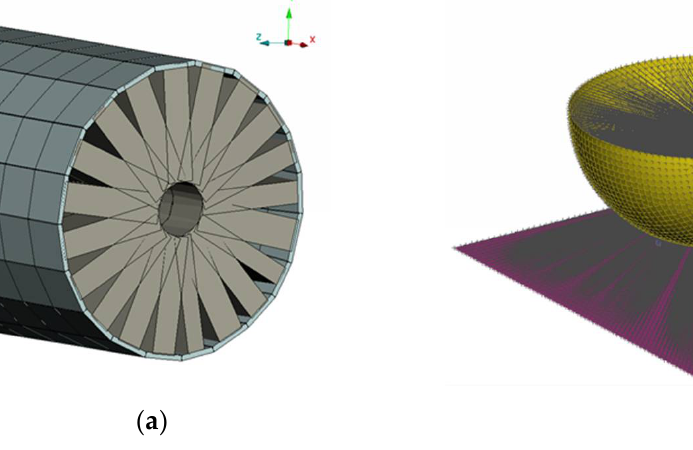
Figure 12. Finite element model of impacted battery: ( a ) model of a cell with case and jelly roll elements and ( b ) impact ball and metal plate models.